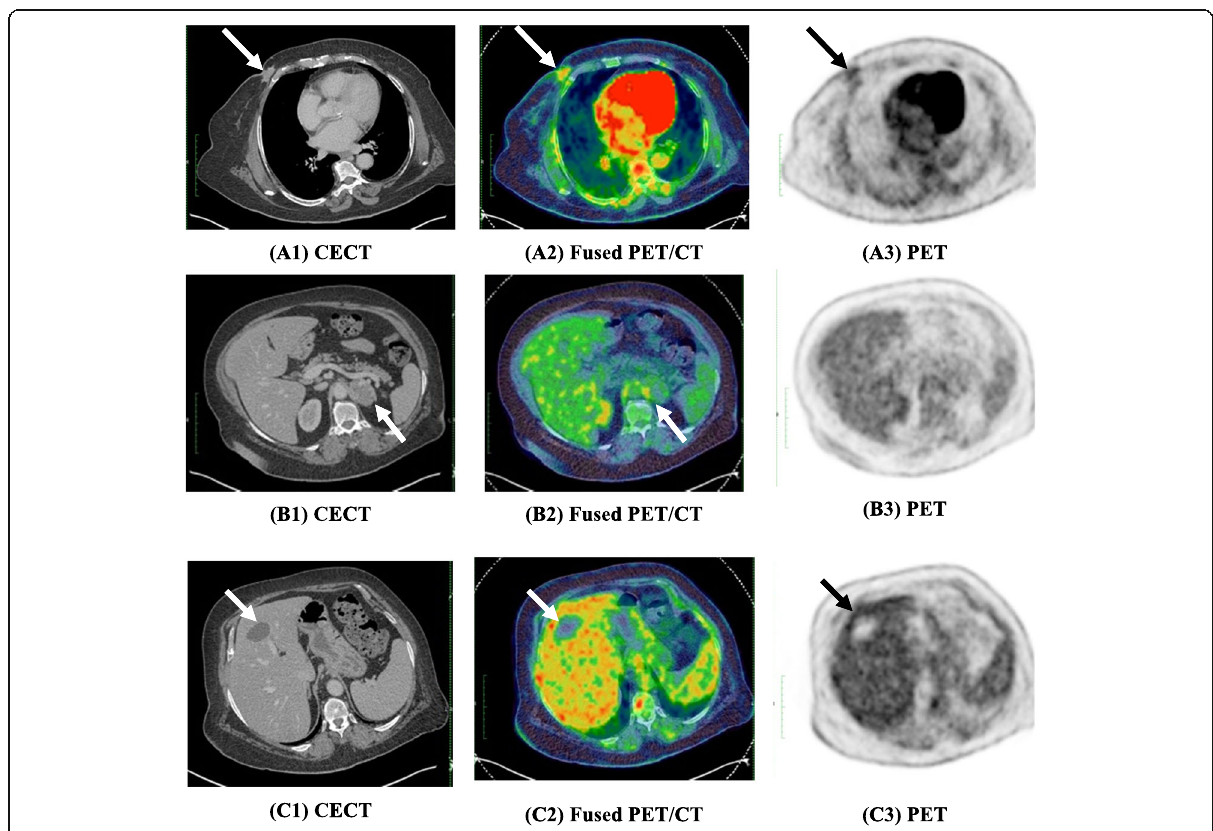
PET axial images show mild marginal increase FDG uptake corresponding to left adrenal mass lesion measuring 5 × 3.7 cm with SUVmax 2.8. (false negative result). c ( 1 , 2 , 3 ) CECT, fused PET CT, and PET axial images show hypodense, non-enhanced segment IV hepatic lesion with no